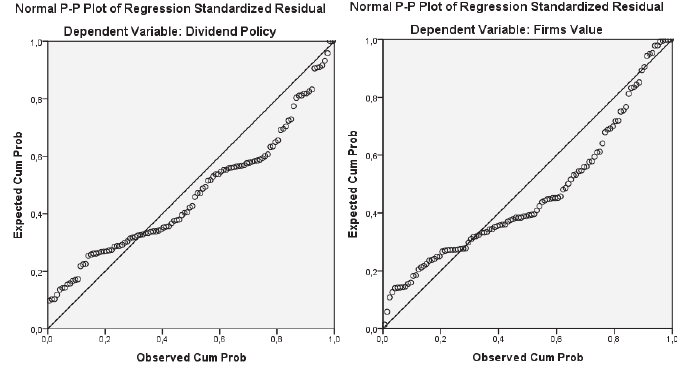
Fig 4 . Normal P-Plot of Dividend Policy & Firms Value frequency